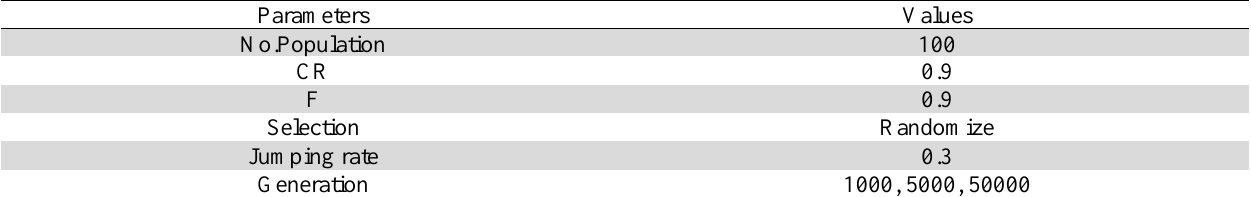
Performance parameters